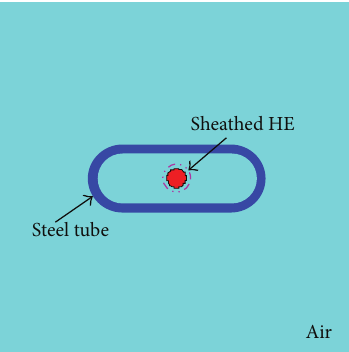
Figure 5: Material location of two-dimensional expanding tube.